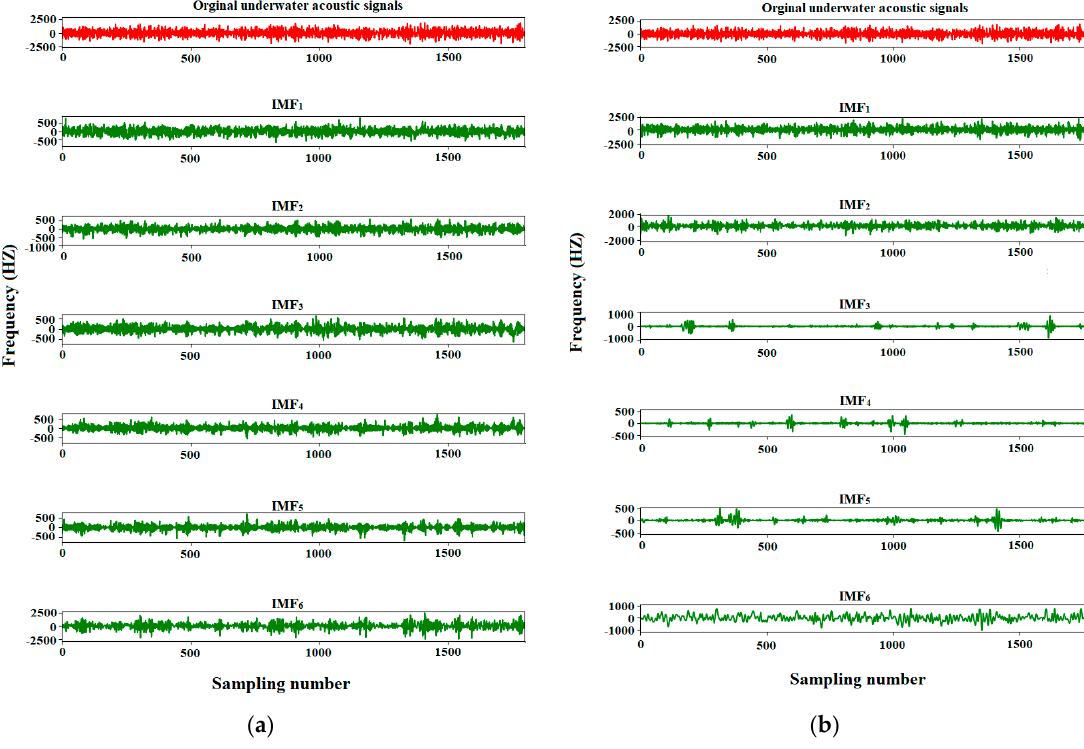
Figure 11. The first 5 intrinsic mode functions (IMFs) waveforms extracted from the empirical mode decomposition (EMD) and MEMD: ( a ) The first 5 IMFs waveforms extracted from the EMD; ( b ) The first 5 IMFs waveforms extracted from the MEMD.